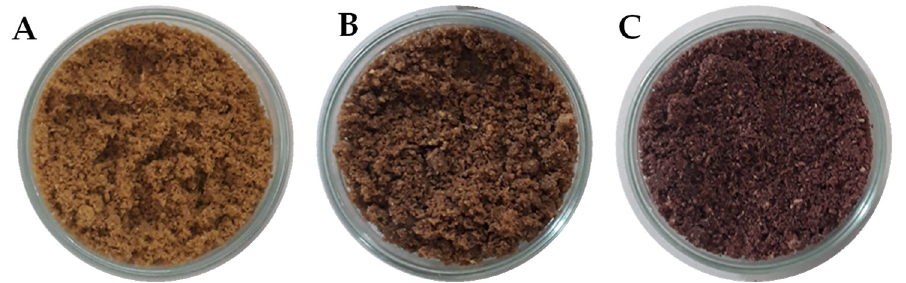
Figure 1. Visual appearance of the table olive flours: ( A ) Green; ( B ) Turning color; ( C ) Black.